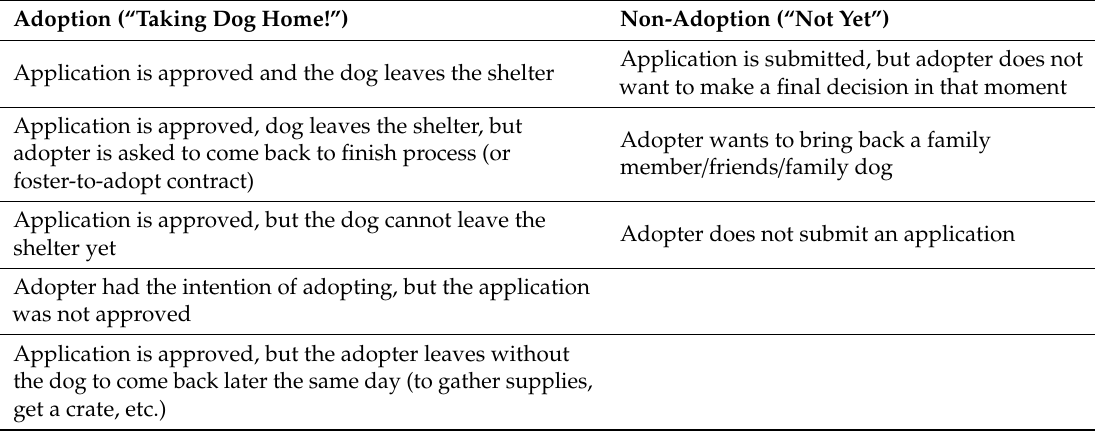
Table 3. Operational definitions of the binary response following a meet-and-greet on the remote data collection